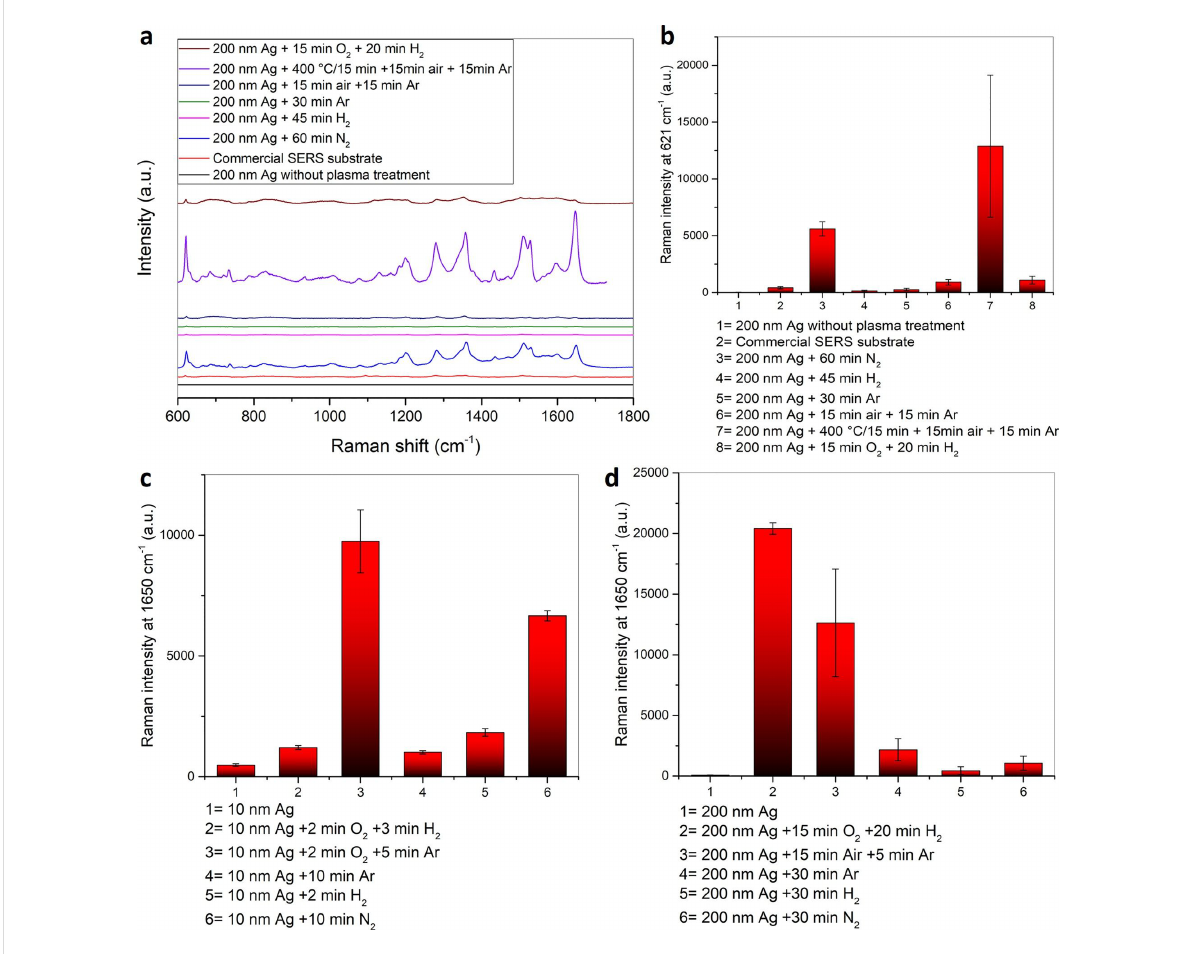
Figure 15: (a) Comparison of the SERS spectra of 10 − 6 M RhB on different SERS substrates and on a commercial SERS substrate using a 632.8 nm laser. (b) Comparison of the average Raman intensities at 621 cm − 1 . Comparison of the average Raman intensities at 1650 cm − 1 on different SERS substrates produced through different plasma treatments on (c) 10 nm and (d) 200 nm sputtered silver films using a 532 nm